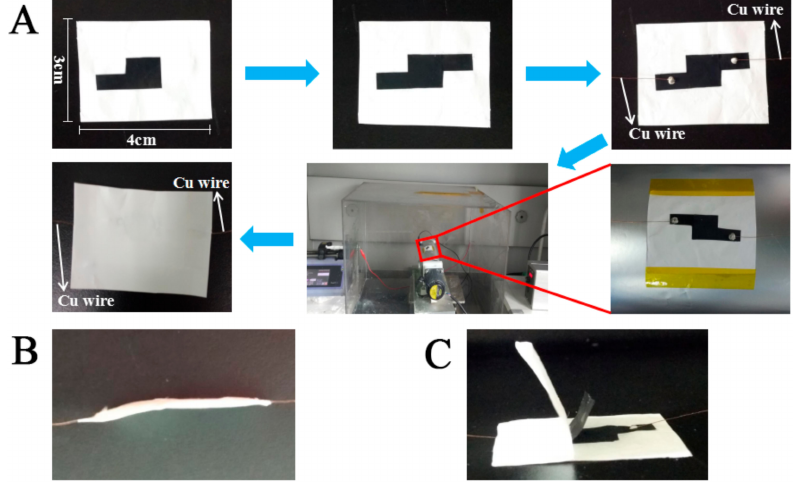
Figure 3. ( A ) Fabrication of a sandwich structured piezoresistive sensor with nanofiber mats as supporting, sensing, and packaging layers via electrospinning; ( B ) Side view of an as-prepared device; ( C ) Side view of a disassembled